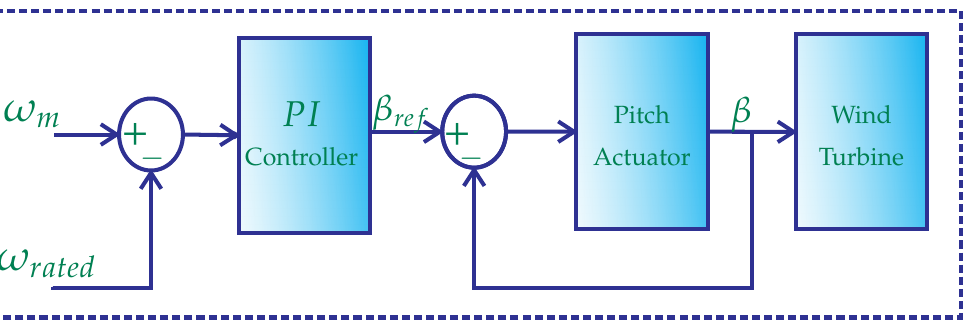
Figure 7. Conventional pitch control scheme for region III operation in PMVG-based